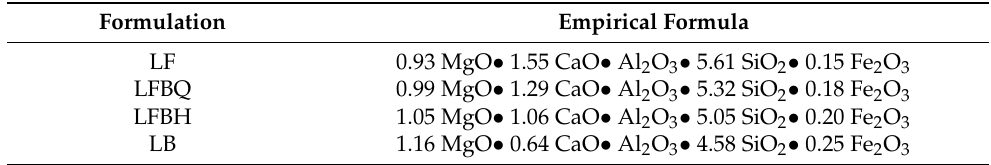
Table 1. Formulation of Porcelain Stoneware